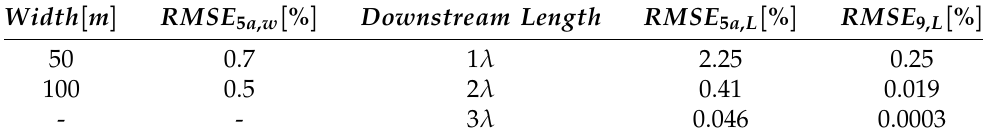
Table 2. Evaluation of NWT’s length downstream the body and NWT’s width. In terms of the length, four lengths have been considered: 1 λ , 2 λ , 3 λ , 4 λ . For the width, three cases have been considered: 50 m, 100 m, 170 m. The RMSE value for the surface elevation at the buoy’s position is calculated, having as reference the case for 4 λ and 170 m for the evaluation of the length and width, respectively. Width [ m